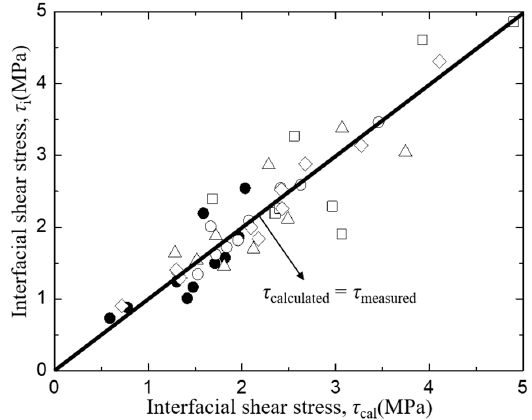
Figure 14. The comparison between the measured and calculated interfacial shear strength of Typha / spp. / Epoxy. Typha spp.